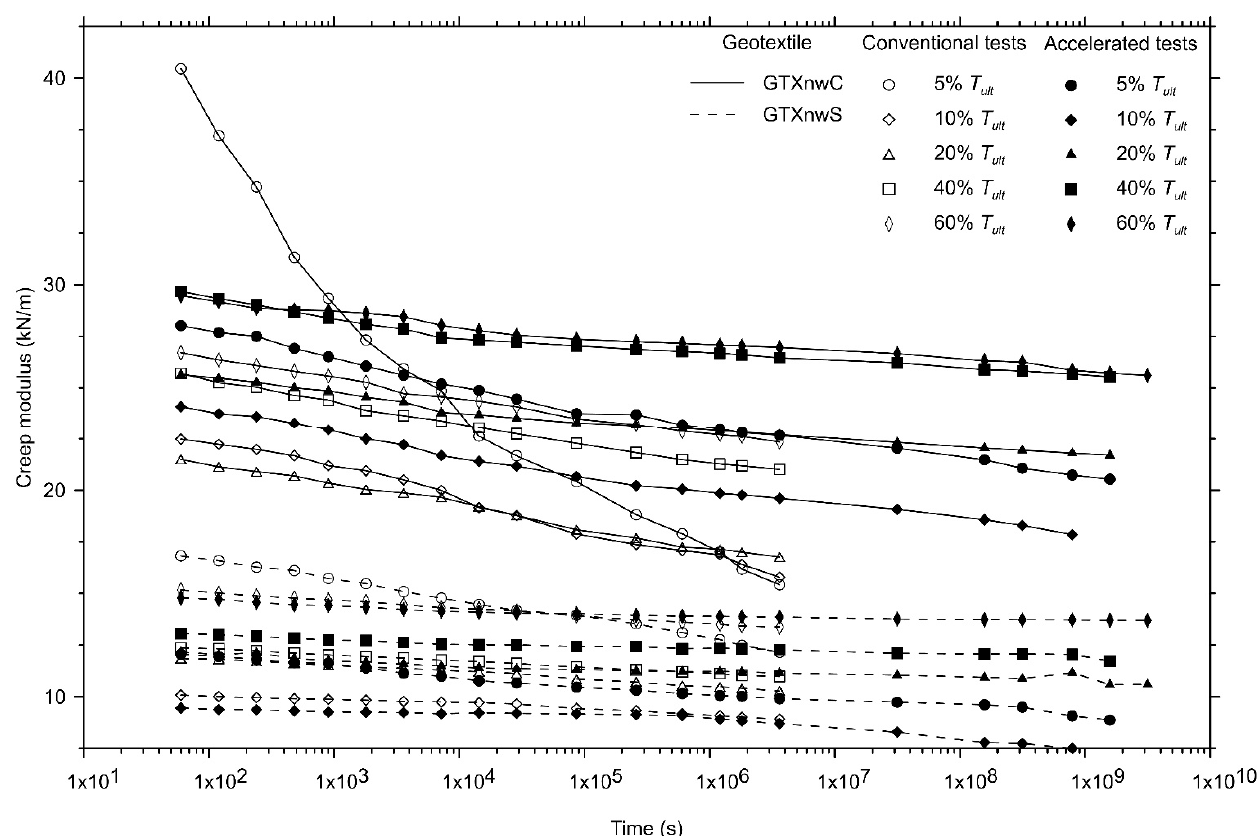
Figure 8. Comparison between the creep modulus obtained using conventional and accelerated creep tests for the non-woven needle-punched geotextile manufactured with continuous filaments (GTXnwC) and with short-staple fibres (GTXnwS).